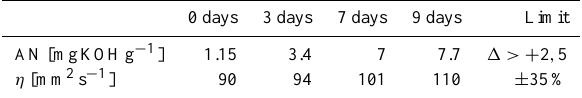
Table 4. Acid number (AN) and kinematic viscosity η for synthetic motor oil (Mobil 1 Pegasus); artificially aged samples, cf. Fig. 4.